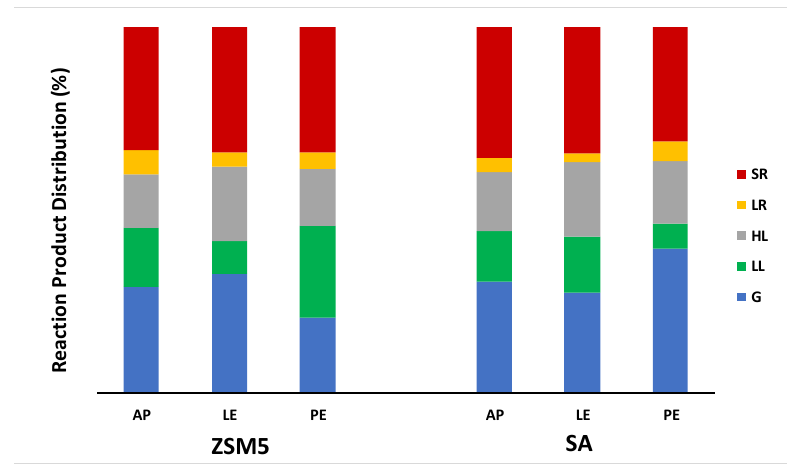
Figure 2. Percentage distribution (%) of products from catalytic pyrolysis of Arthrospira platensis biomass without any pretreatment (AP), after lipid extraction (LE), and after protein extraction (PE). G, reaction gas; LL, light reaction liquid; HL, heavy reaction liquid; LR, liquid residue; SR, solid residue.